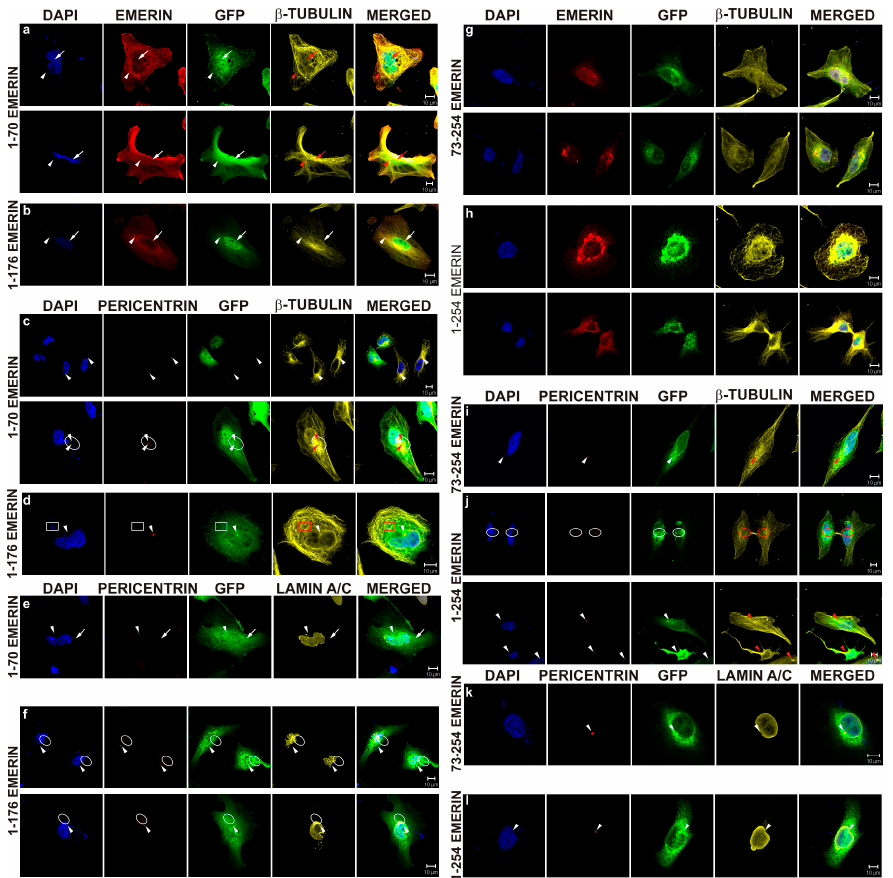
Figure 5. Overexpression of entire emerin and emerin fragments containing different domains in HeLa cells. Depending on the protein fragment introduced into the cell, we observed different effects manifested by disorder in the process of nuclear reassembly, maintenance of nuclear shape, and the microtubule network. For details, see main text. HeLa cells were transfected with plasmids coding for GFP fusion proteins (E70, E176, E73-254, or E254), placed on coverslips, fixed with 4% PFA, and stained with antibodies against emerin (red, a , g , h ), pericentrin (red, c – f , i – l ), β -tubulin (yellow, a – d , g – j ), and lamin A/C (yellow, e , f , k , l ). a , b : -arrows in a,b point the aberrant nuclei lacking endogenous emerin; arrowheads point the endogenous cytoplasmic emerin fraction. c – l : -arrowheads indicate the location of centrosomes; circles define the regions with multiple staining for pericentrin; boxes define the regions with extra nuclear DNA/chromatin. Single Z-stacks 1.5 μ m. Scale bar, 5 μ m. Note that transfection of cells with E70 mutant (also frequently with E176 mutant) induced, besides irregular and fragmented cell nuclei, also the presence of chromatin loci in cytoplasm (Figure 5a,c,d).